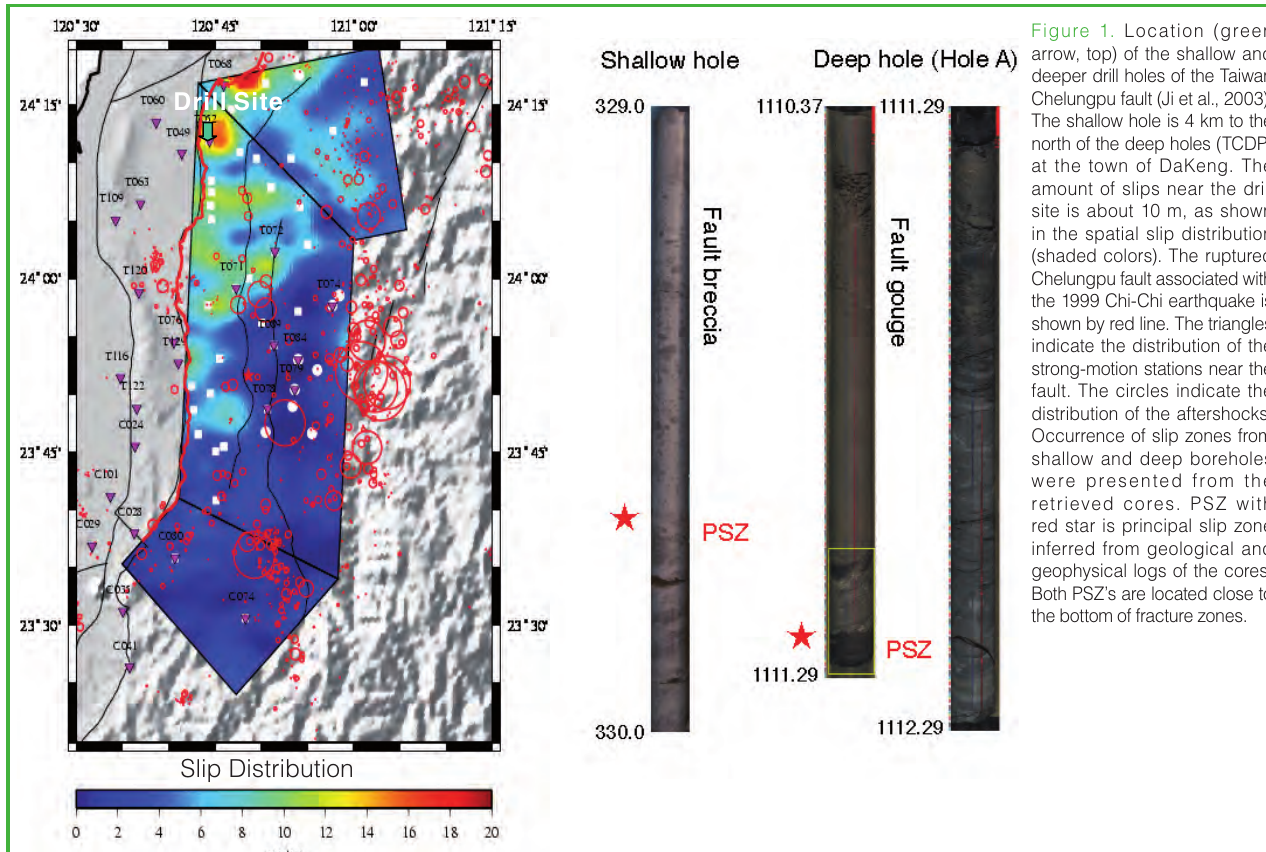
Figure 1. Location (green arrow, top) of the shallow and deeper drill holes of the Taiwan Chelungpu fault (Ji et al., 2003). The shallow hole is 4 km to the north of the deep holes (TCDP) at the town of DaKeng. The amount of slips near the drill site is about 10 m, as shown in the spatial slip distribution (shaded colors). The ruptured Chelungpu fault associated with the 1999 Chi-Chi earthquake is shown by red line. The triangles indicate the distribution of the strong-motion stations near the fault. The circles indicate the distribution of the aftershocks. Occurrence of slip zones from shallow and deep boreholes were presented from the retrieved cores. PSZ with red star is principal slip zone inferred from geological and geophysical logs of the cores. Both PSZ’s are located close to the bottom of fracture